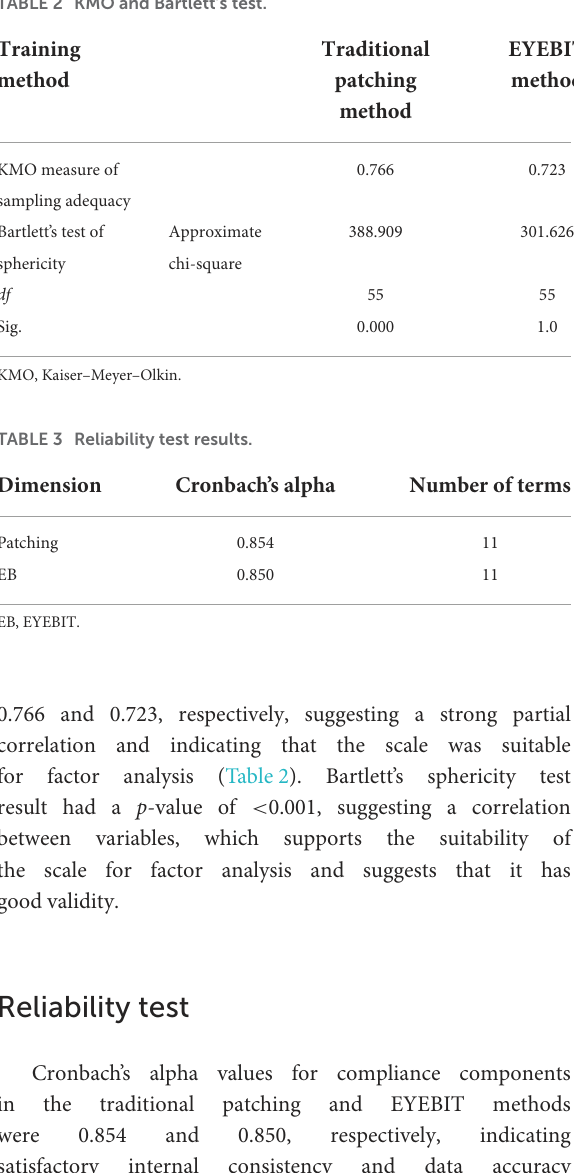
TABLE 2 KMO and Bartlett’s test.